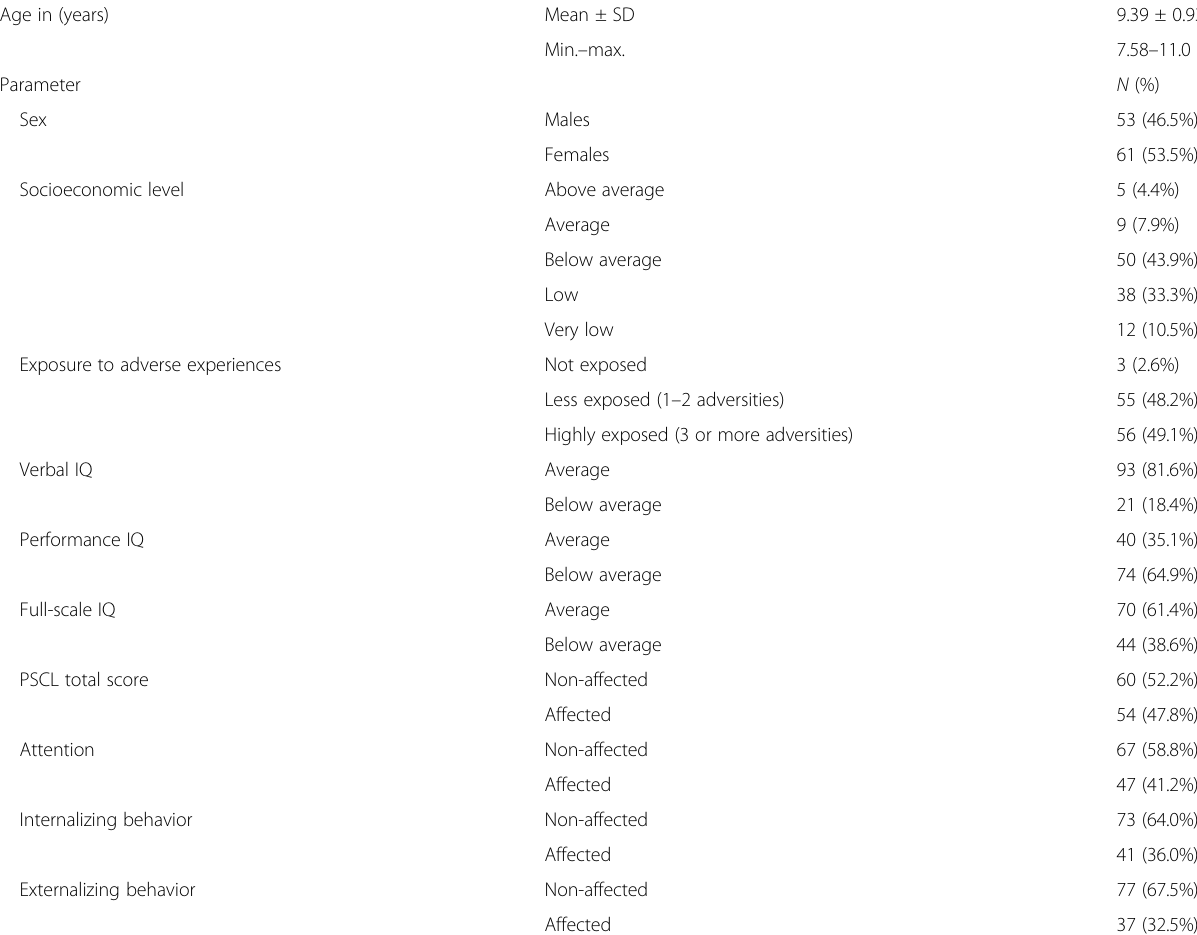
Table 1 Characteristics of the studied